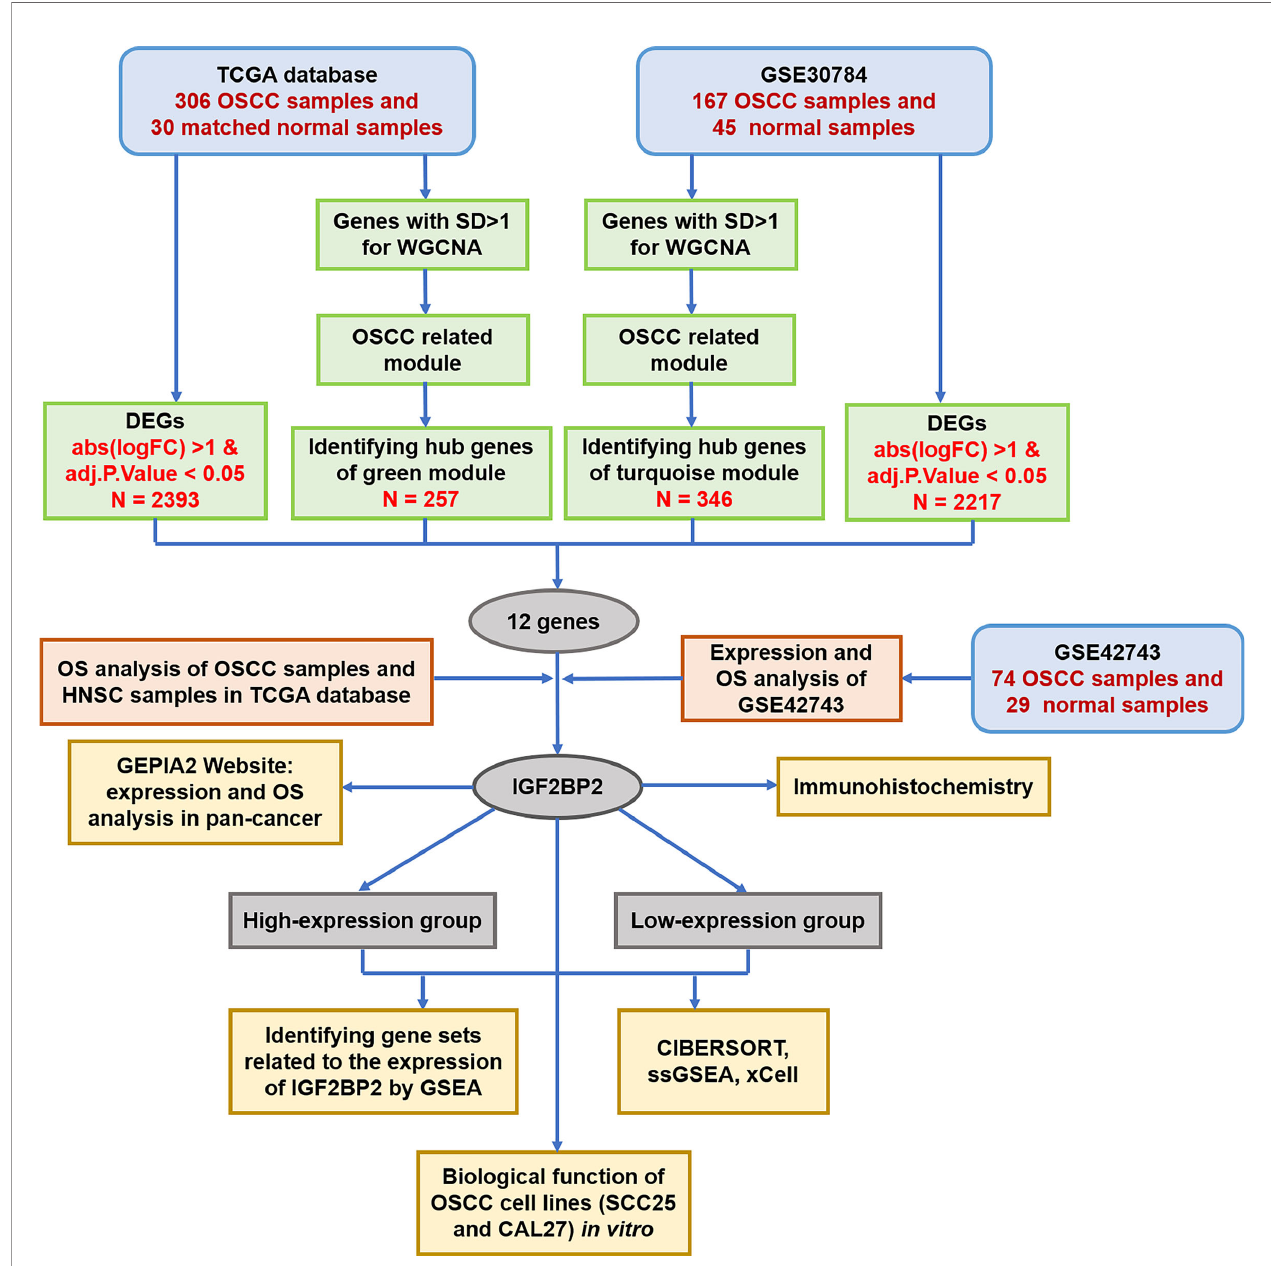
FIGURE 1 | Flowchart of the data preparation, screening, analysis and validation. TCGA, The Cancer Genome Atlas; OSCC, oral squamous cell carcinoma; SD, standard deviation; WGCNA, weighted gene coexpression network analysis; DEGs, differentially expressed genes; OS, overall survival; HNSC, head and neck squamous cell carcinoma; IGF2BP2, insulin-like growth factor 2 mRNA binding protein 2; GEPIA, gene expression pro fi ling interactive analysis; GSEA, gene set enrichment analysis; ssGSEA, single-sample gene set enrichment